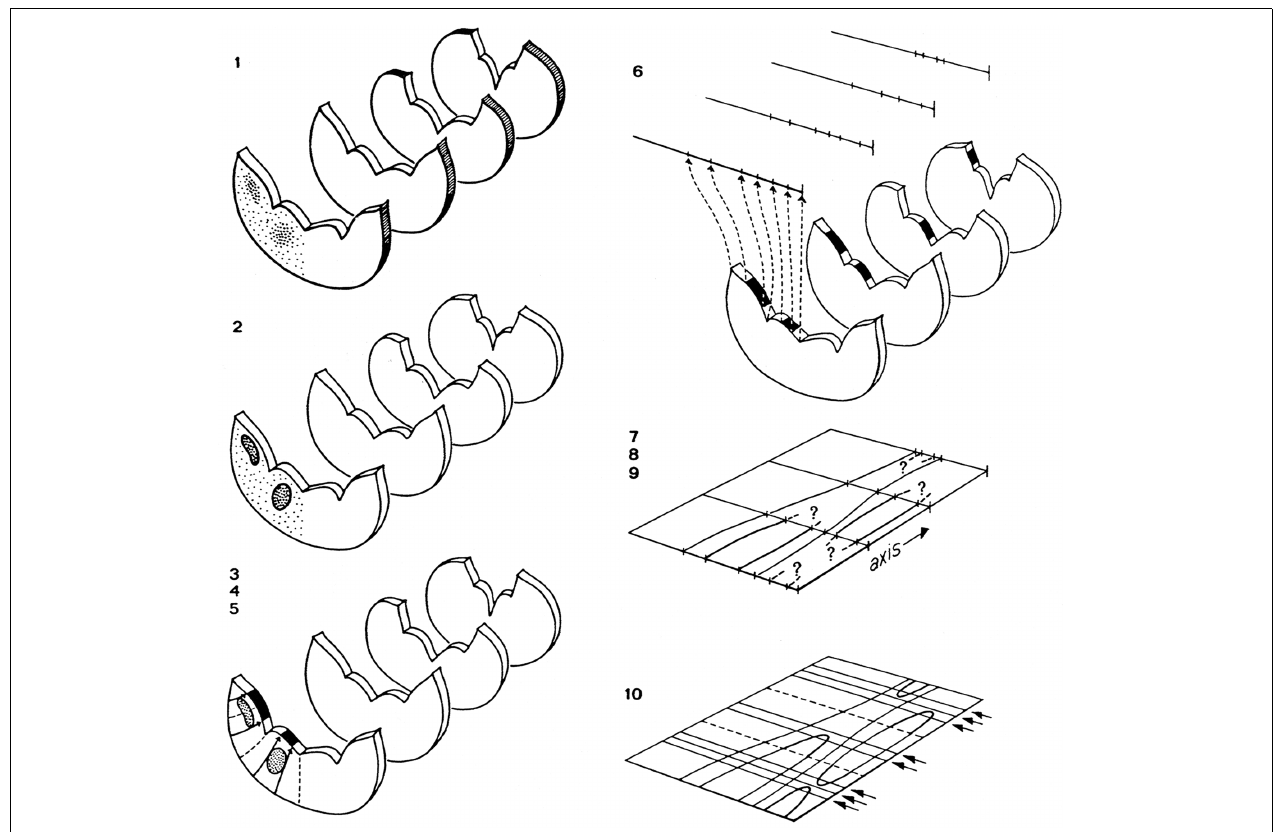
straight line; (7) introduction of an orthogonal system of coordinates; (8) transfer of the lines representing the ventricular surfaces of the sections to the coordinate system; (9) connection of corresponding points; (10) collection of additional data concerning the beginning and the end of ventricular sulci and cell masses, and completion of the